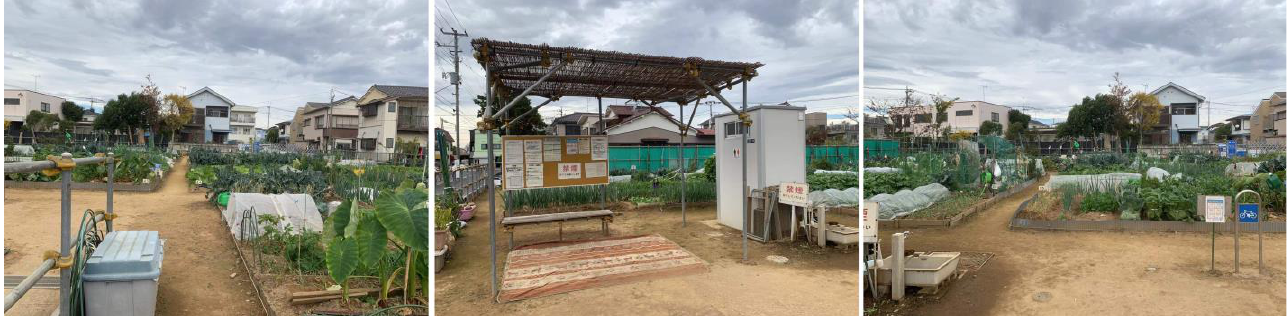
Figure 1. Typical AGs in Tokyo. Source: authors.